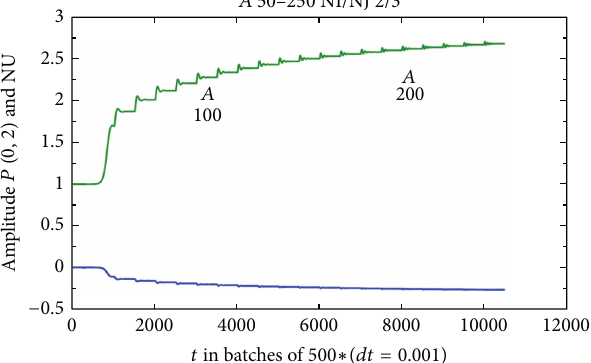
Table 2: Amplitude array grid 7 × 5 , 𝑅